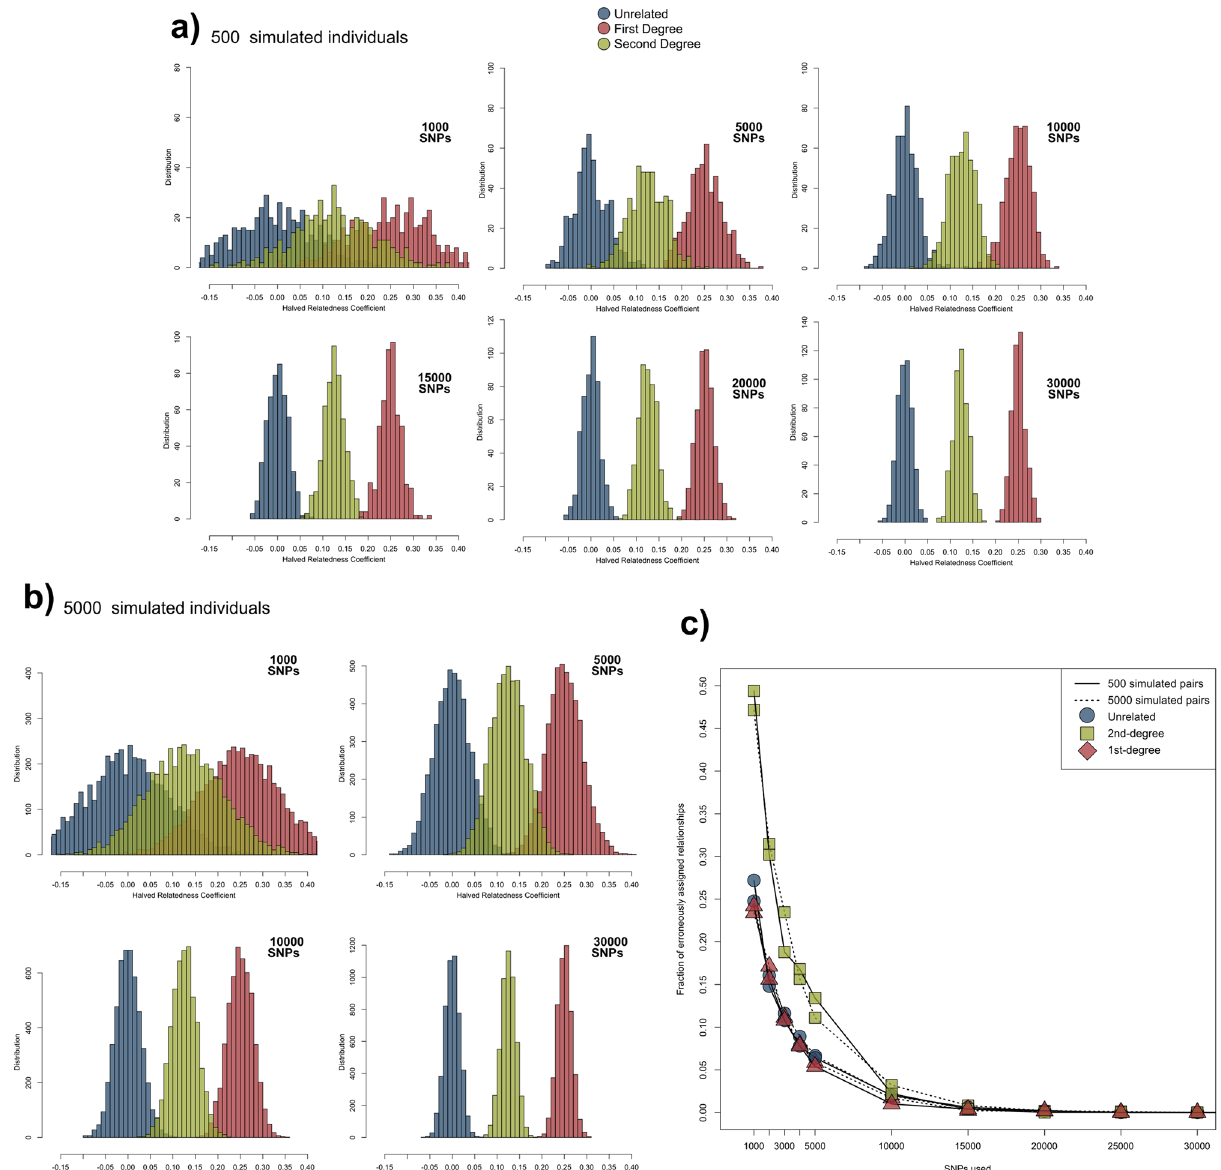
Figure 3. Coefficient distribution ranges for ( a ) 500 and ( b ) 5000 pairs of simulated individuals using different numbers of SNPs, based on Phase 1 CHS allele frequencies, demonstrating overlaps and the correction of the curves towards the hard thresholds between classes on the higher SNP numbers. ( c ) False positive rates, as identified by simulated relationships crossing the thresholds between classes. From 30,000 SNPs no overlap was obtained, even with up to 5000 simulated pairs of individuals, although higher numbers of simulated pairs would eventually produce an overlap with error rates further tending towards Figure 3a). The non-normalised P0 values confirm that there is not a completely clear separation of individuals based on their expected relationship, especially in regards to the unrelated and 2nd-degree classes (Supplemen- tary Table 7). Using the 3,000,000 reads threshold there is an apparent better separation but there is still a lack of enough variation to be able to properly identify relatives, with the “max” normalisation setting detecting some 2nd-degree relatives but still unable to detect any 1st-degree relatives (Supplementary Figure 3b). We tried to understand if these results were caused by lack of data or by the use of the genome-wide SNP dataset. To do so, we extracted the Koszyce individuals genotyped to the variants in the 1240K dataset 18 from the Allen Ancient DNA Resource v44.3 (https:// reich. hms. harva rd. edu/, accessed on 20.03.2021) and randomly downsampled them to have similar numbers of overlapping SNPs as when we used the 1,300,000 reads and our genome-wide dataset. This corresponded to around 3300 SNPs per pair. By using SNPs from the 1240K dataset READ is in fact able to correctly assigned all 12 1st-degree relationships, as well as 23 of the 32 2nd-degrees (although here 11 had high uncertainty reflected in values of |Z| < 1) (Supplementary Figure 3c, Supplementary